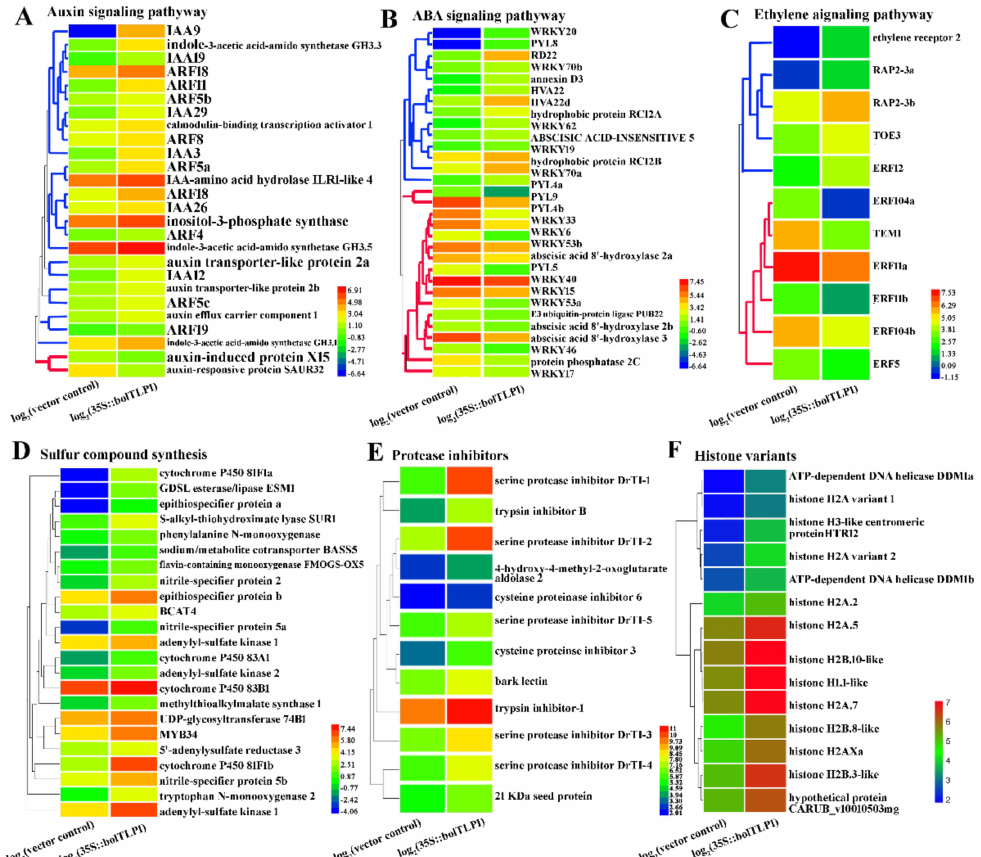
Figure 6. Transcriptional expression patterns of the differentially expressed genes involved in phytohormone-mediated signaling pathways ( A – C ), sulfur compound synthesis ( D ), protease in- hibitors ( E ) and histone variants ( F ). The blue and red branches in ( A – C ) indicated the genes displayed significantly up-regulated and down-regulated expression in the 35S:: bolTLP1 broccoli compared with the vector control (corrected p -value < 0.01), respectively. Log 2 (35S::bolTLP1) and log 2 (vec- tor control) indicated the log 2 FPKM of bolTLP1 in 35S:: bolTLP1 broccoli and vector control plants, respectively, which represents the normalized expression level of bolTLP1 detected by